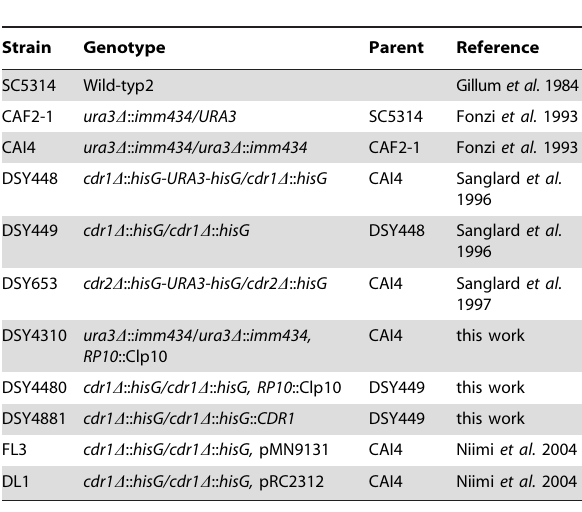
Table 1. Isogenic C. albicans strains used in this